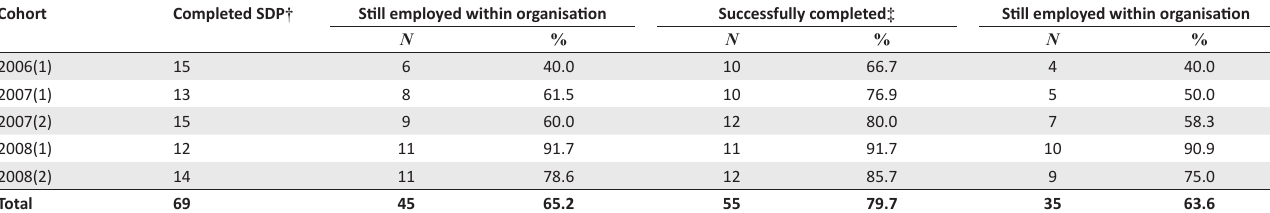
TABLE 5: Comparison of participants completing and successfully completing the supervisory development programme and still employed within the organisation from 2006 to 2008.